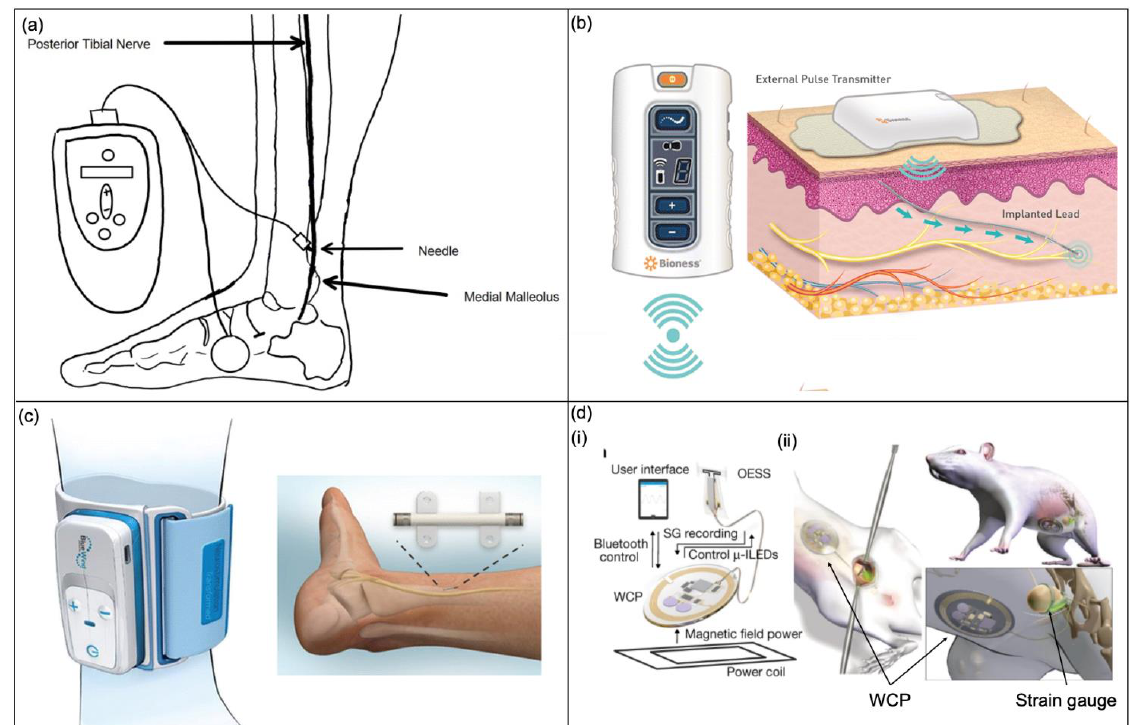
Figure 9. Stimulation devices to treat OAB. ( a ) Posterior tibial nerve stimulation (PTNS) device [46]. ( b ) The implanted Bio Stimrouter system with a patient programmer to control external pulse trans- mitter [53]. Copyright 2017, Springer Nature. ( c ) The BlueWind RENOVA system implanted adja- cent to the PTN and external control unit around the ankle [53]. Copyright 2017, Springer Nature. ( d ) ( i ) A schematic of the optogenetic stimulation system — an optoelectronic stimulation and sens-